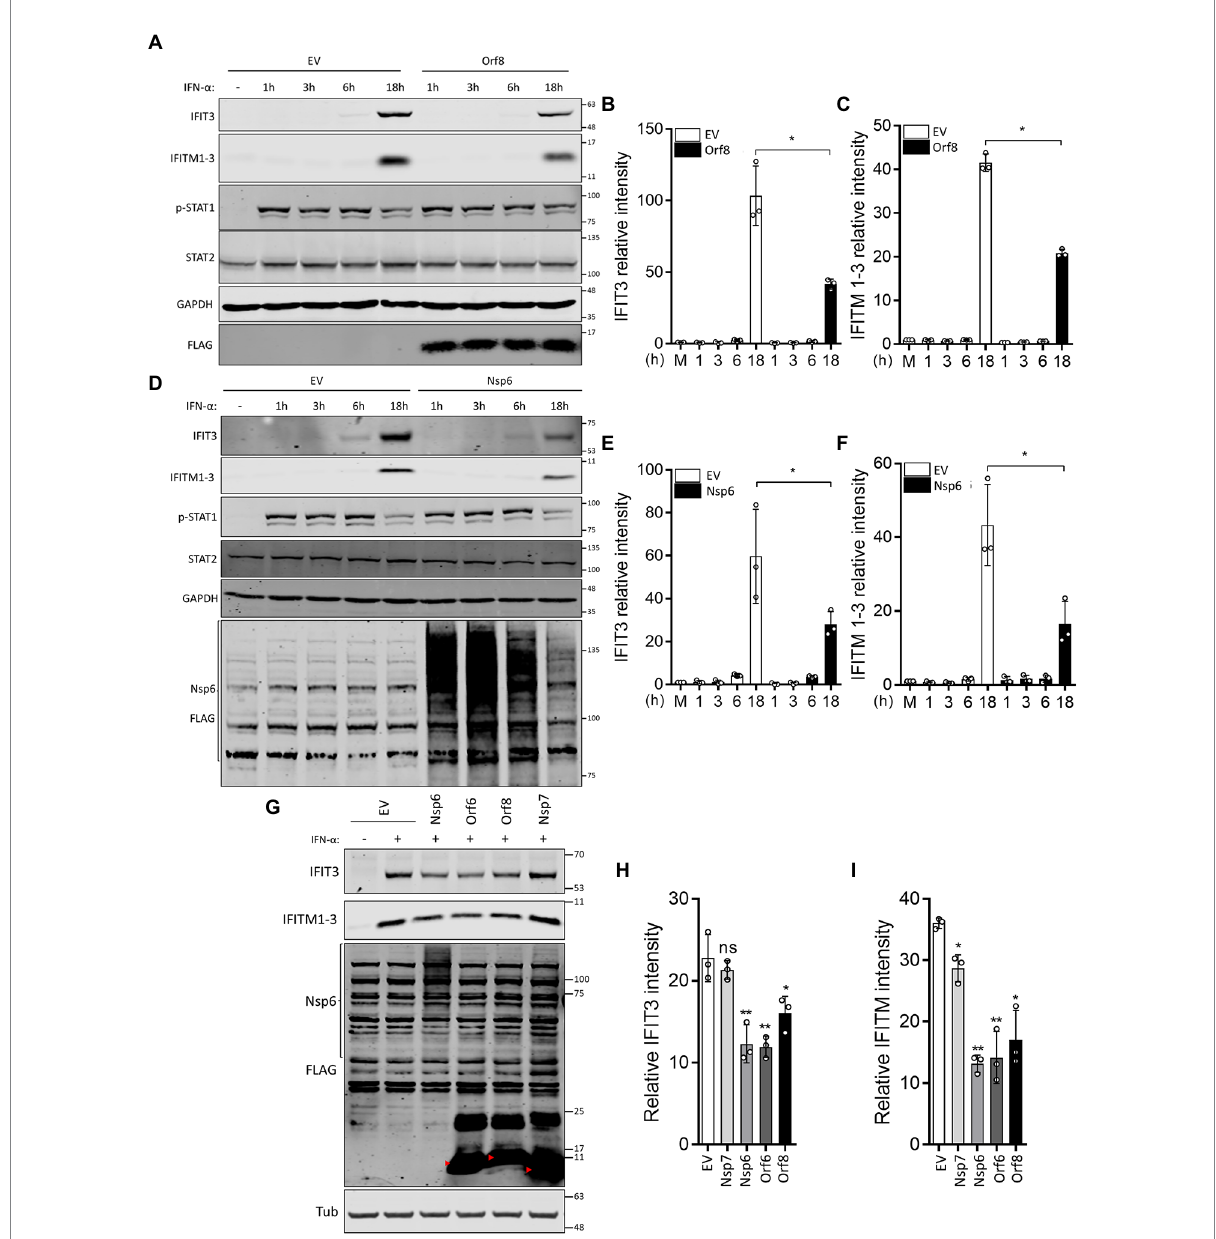
FIGURE 4 SARS-CoV-2 Orf8 and Nsp6 suppress IFN- α -induced ISG expression. (A) Immunoblots showing the levels of IFIT3, IFITM1-3, STAT2 and p-STAT1 expression at different times after IFN- α treatment in the presence or absence of Orf8. (B,C) Quantification of band intensities for IFIT3 (B) and IFITM1-3 (C) from 3 separate experiments. (D) as for (A) except that Nsp6 was expressed rather than Orf8. (E,F) Quantification of band intensities for IFIT3 (E) and IFITM1-3 (F) from three separate experiments. (G) Immunoblots showing the levels of IFIT3 and IFITM1-3 18 h after IFN- α treatment in the presence or absence of the indicated viral proteins or empty vector (EV). (H,I) Quantification of band intensities for IFIT3 (H) and IFITM1-3 (I) from 3 separate experiments. GAPDH (A,D) or tubulin (G) were used as loading controls. Error bars show standard deviation. The p - values were relative to EV. (* p < 0.05 and ** p < 0.01). For immunoblots, the positions of molecular mass markers in kDa are indicated on the right and the positions of the SARS-CoV-2 proteins are indicated by red